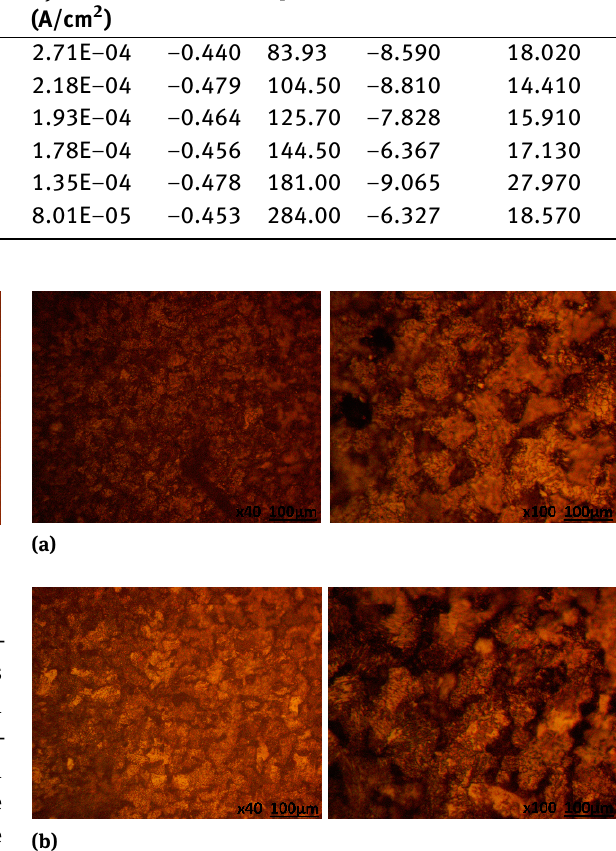
Figure 3: Optical images of LCS surface after polarization from (a) H 2 SO 4 solution and (b) HCl solution at 0% TMAV concentration